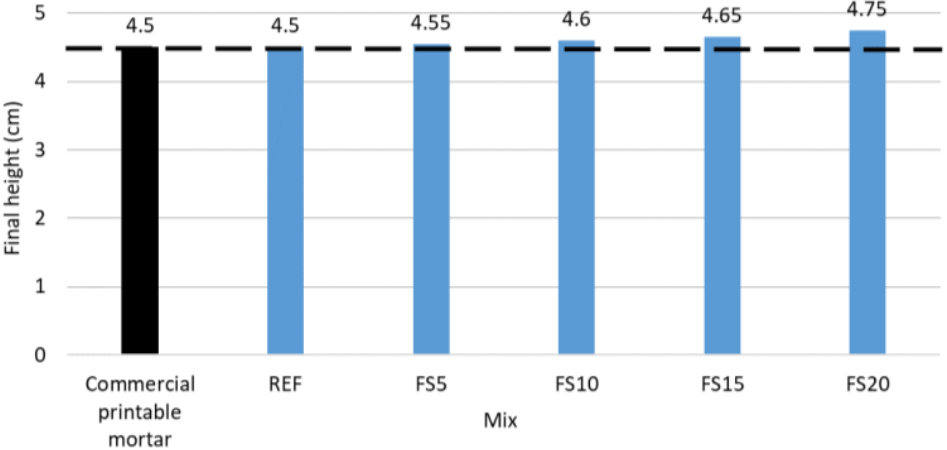
Figure 6. Buildability of mixtures using the modified minislump test.